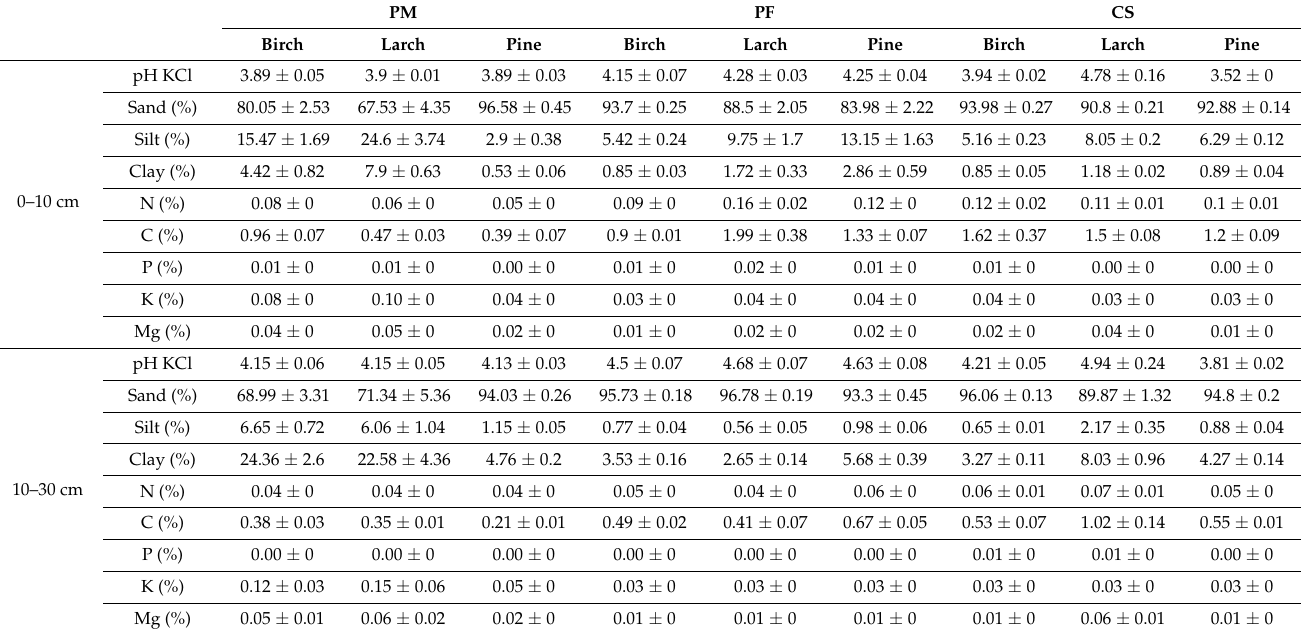
Table 1. Basic soil properties under birch, larch, and pine growing on reconstructed forest ecosystem (PM), regenerated forest ecosystem (PF), and control plots (CS) (mean ± SE) [43]. PM PF CS Birch Larch Pine Birch Larch Pine Birch Larch